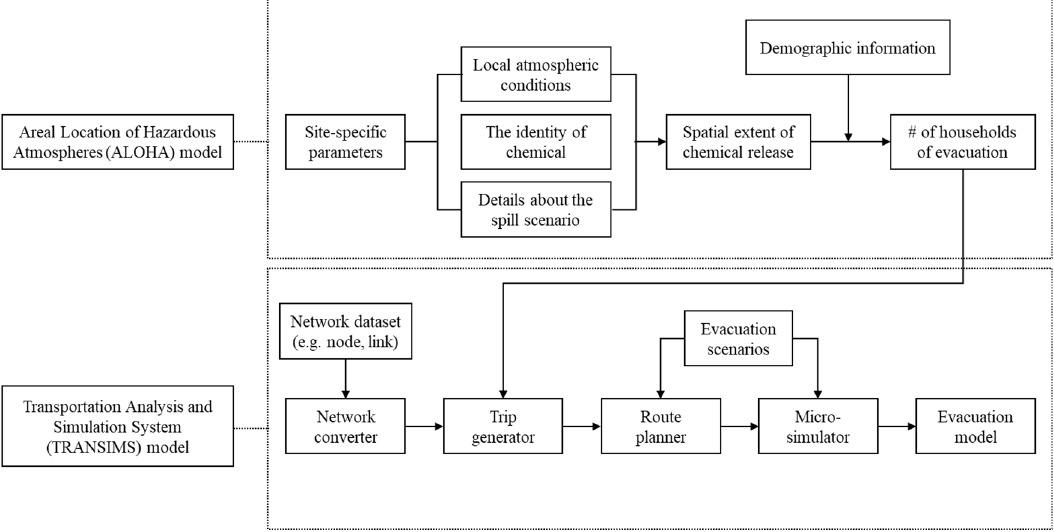
Figure 3. Modeling framework of the study.